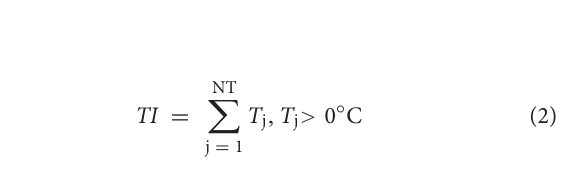
FIGURE 1 | Geographic location of the study area and the 34 meteorological stations